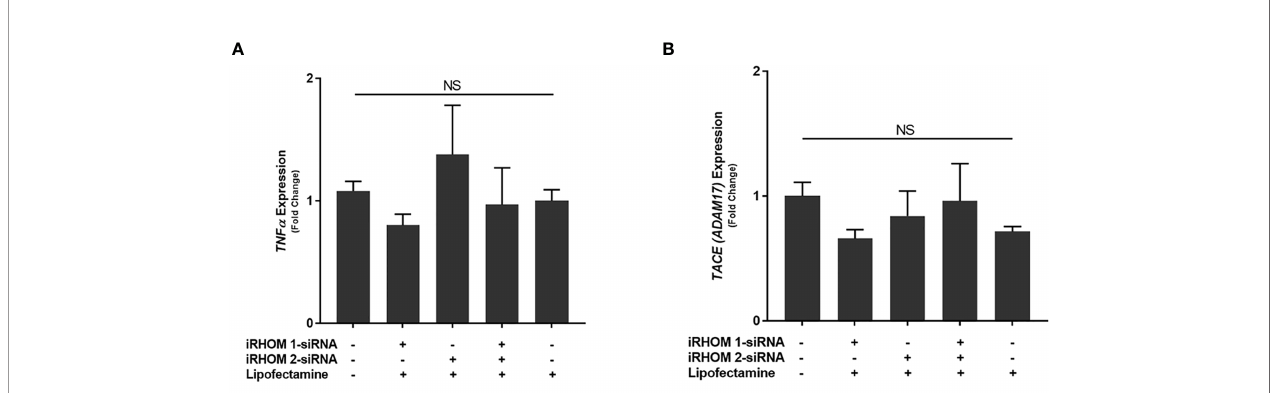
FIGURE 4 | The impact of an iRHOM 1/2 siRNA mock transfection of the expression of (A) TNF- a and (B) TACE . The Kolmogorov – Smirnov normality test was used to test the normal distribution for all values and a two-way analysis of variance (ANOVA) was used to assess signi fi cance among experiments, which was followed by a Bonferroni correction test. All experiments were performed in triplicates. The difference in gene expression among the control and treated groups was not signi fi cant (NS).